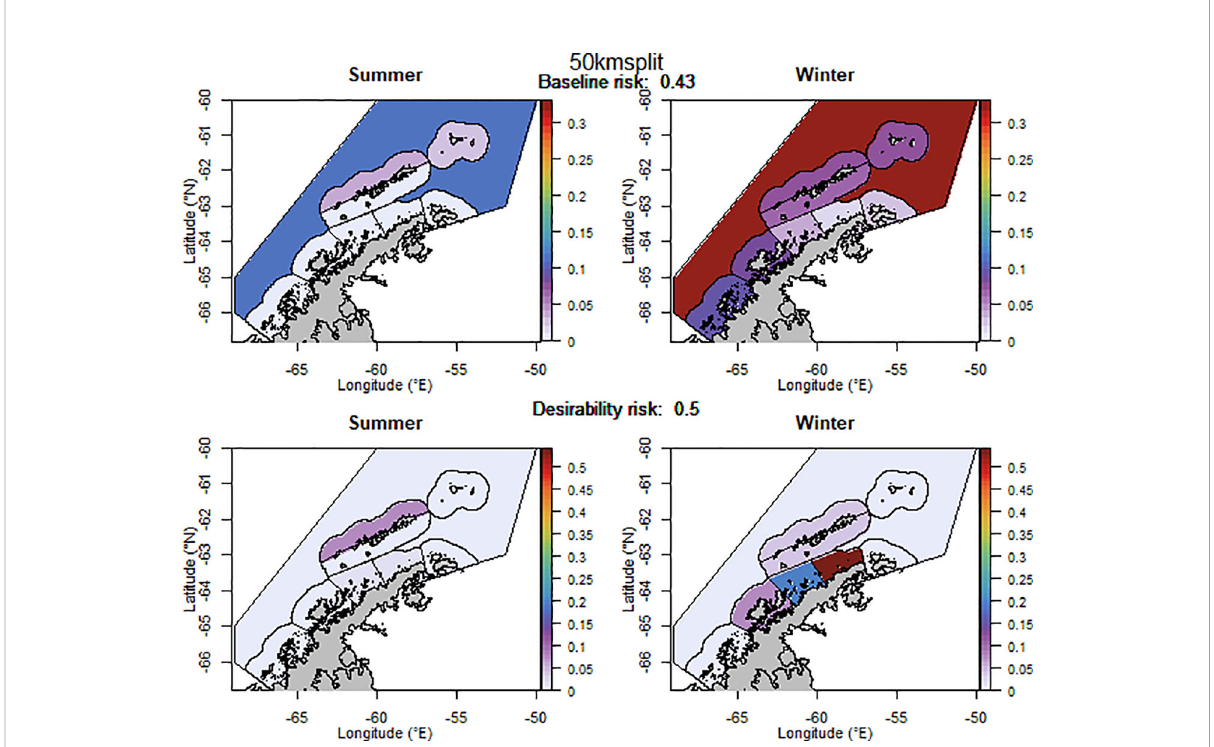
FIGURE 6 The proportion of the annual krill catch limit that could be taken from each management unit (delineated using the 50 km buffer from land divided into smaller management units) during summer and winter when the risk assessment was implemented after the winter krill layer was adjusted. Values sum to 1 across all management units and for both seasons for each of the baseline (upper panel) and desirability (lower panel)